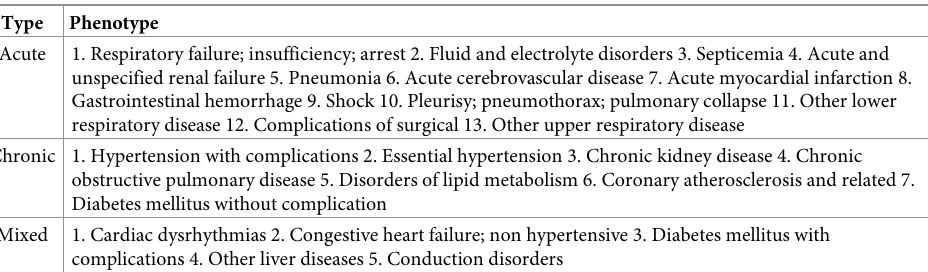
Table 4. Phenotype categories.